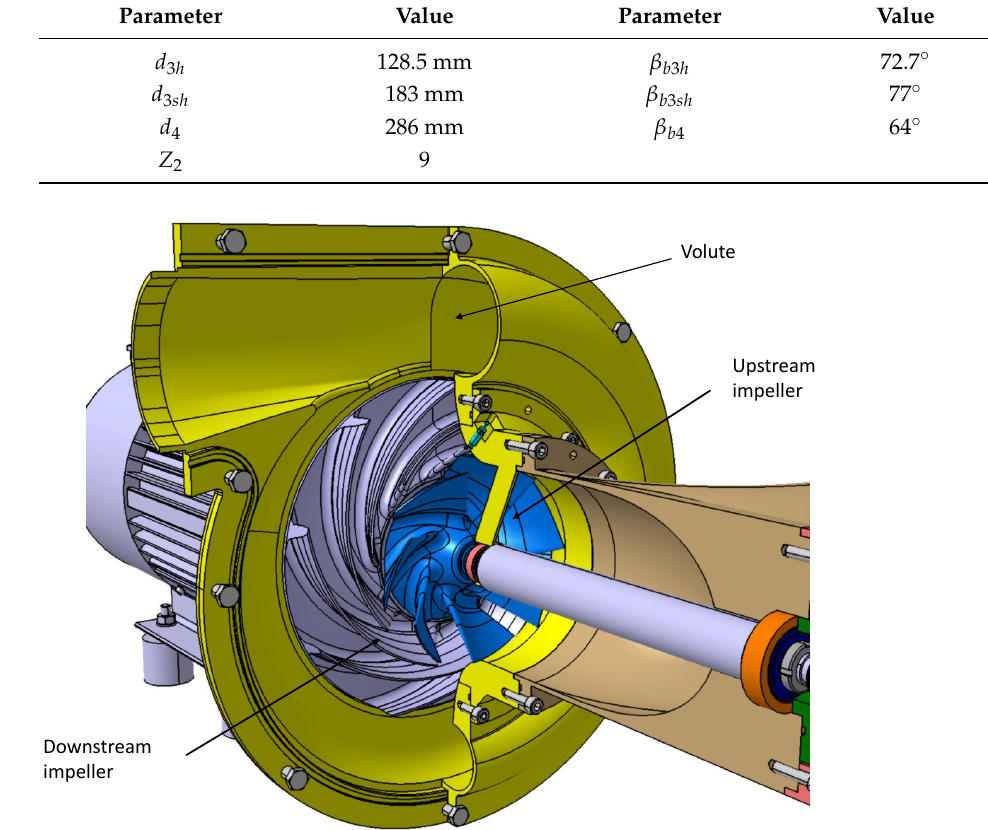
Figure 1. Structure of the twin-impeller centrifugal compressor